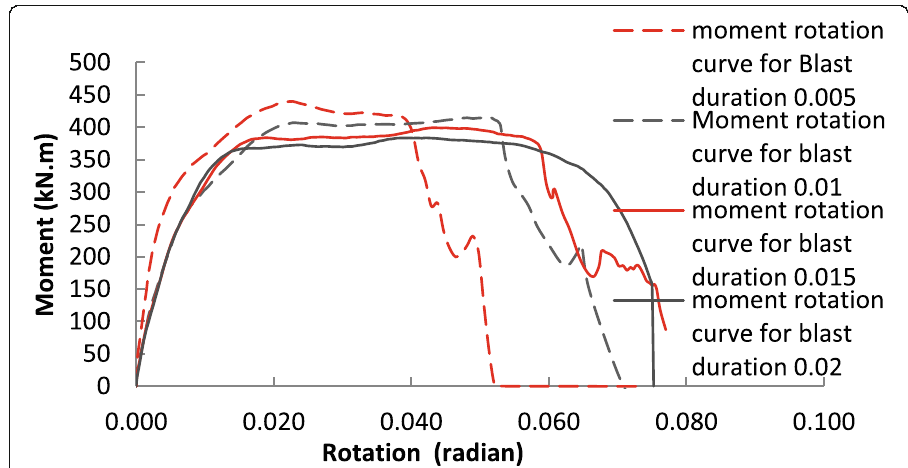
Fig. 25 Connection SC2 — summary of the moment-rotation curve for all blast durations